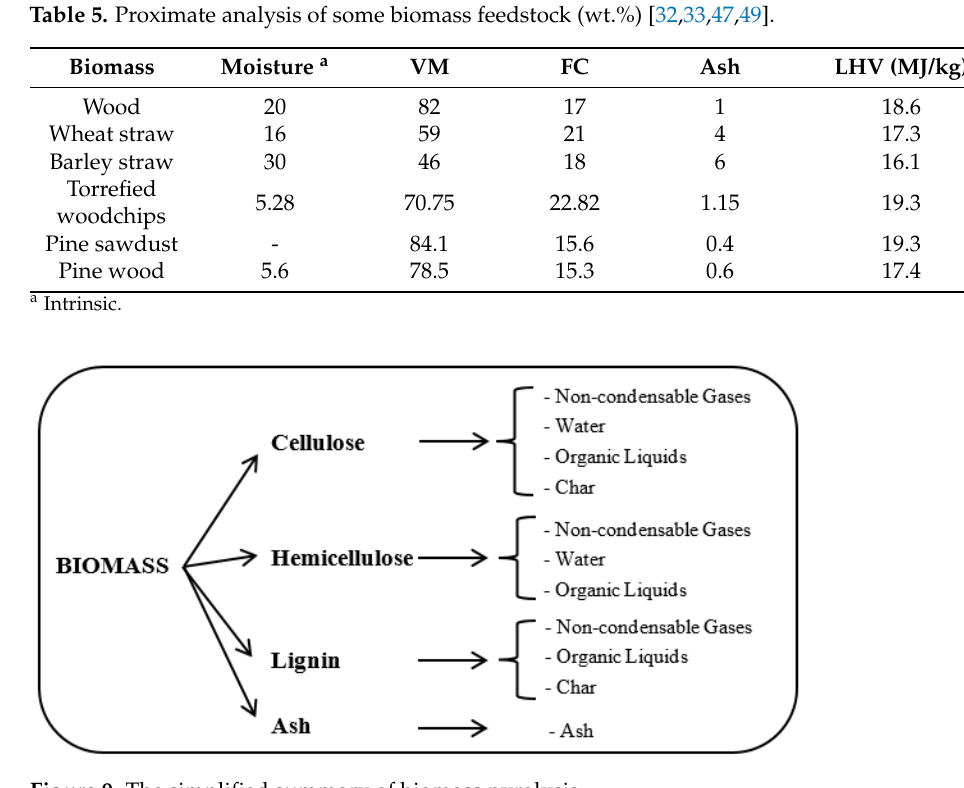
Table 5. Proximate analysis of some biomass feedstock (wt.%) [32,33,47,49] .